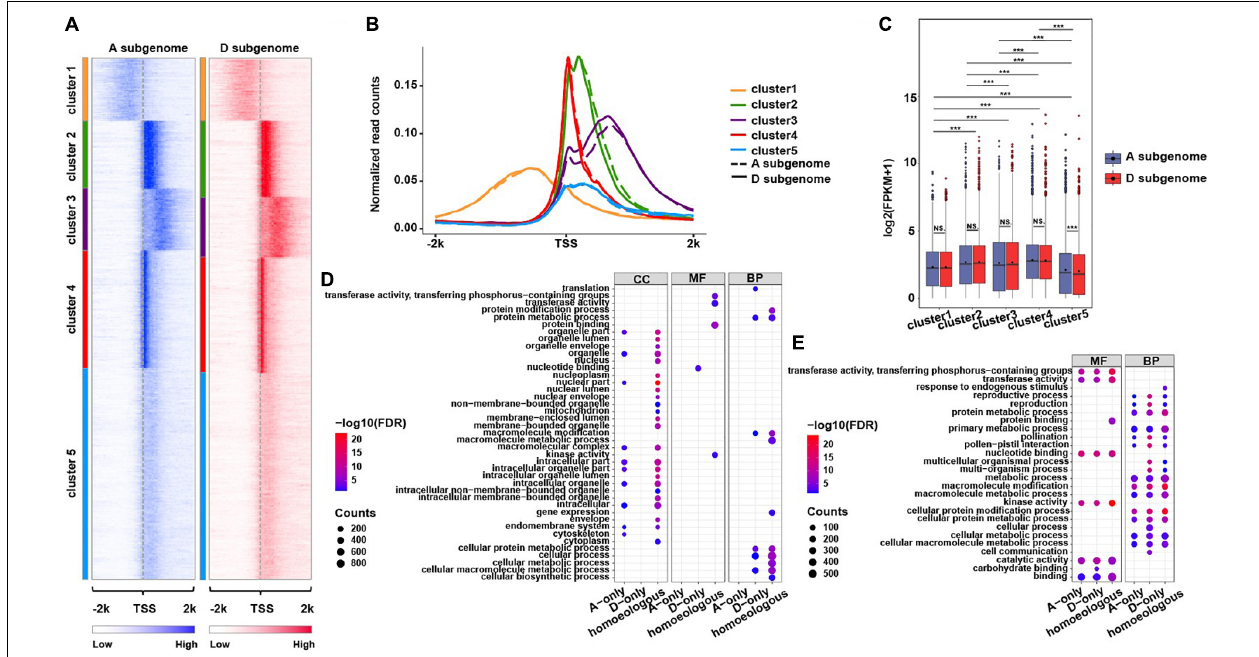
FIGURE 3 | Distribution of H3K4me3 mark around TSSs of the genes in two subgenomes. (A) Heatmaps showing five k -means clusters for H3K4me3 distributed around ± 2 kb of TSSs of the overlapping genes in A and D subgenome. The color represents H3K4me3 enrichment levels. (B) The profiles of normalized H3K4me3 read counts around ± 2 kb of TSSs of the genes from each cluster characterized in (A) . (C) The boxplots show expression levels of the genes from each cluster in two subgenomes. A significance test was determined using the Wilcoxon rank-sum test, *** p < 0.001. (D,E) Functional GO term enrichment analyses of the genes from Cluster1 (D) and Cluster3 (E) , the related genes were divided into three types, A subgenome-only, homeologous (homeologous gene pairs in the same cluster in A and D subgenome) and D subgenome-only, the size of each dot represents the number of genes, and the color key indicates – log10 (FDR).